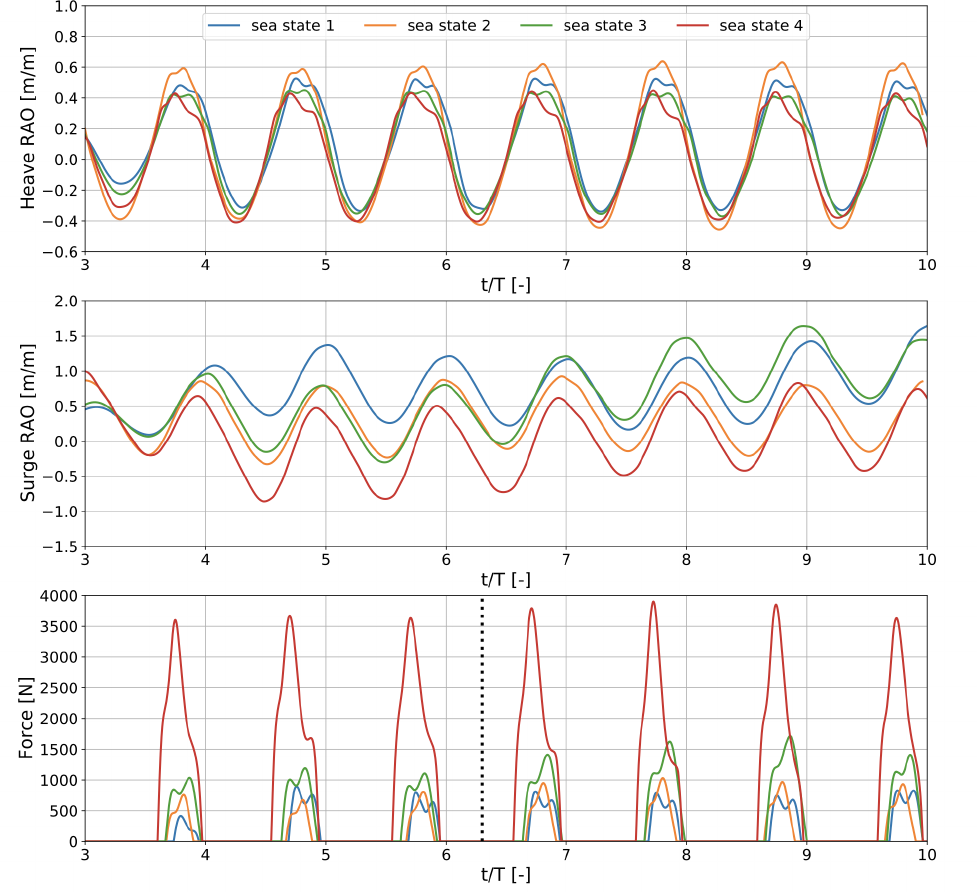
Figure 12. Results from CFD simulations of sea state